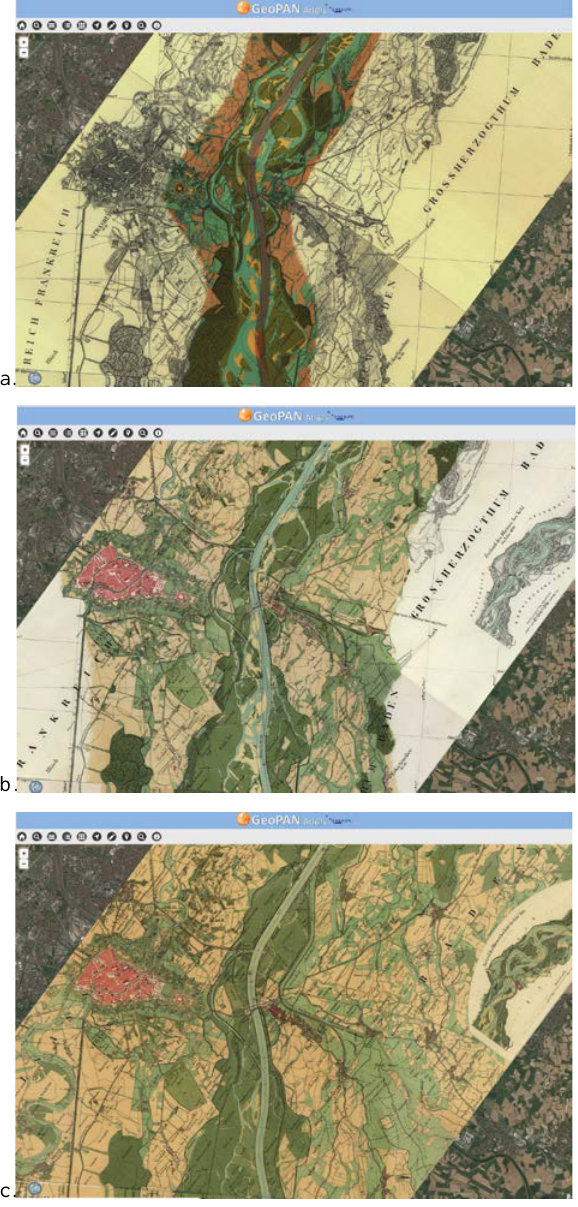
Figure 5. Rhine river in correspondence of Strasbourg: the original riverbed in 1830 (light blue) and the rectification project (red) (a), the riverbed (light blue) in 1852 (b) and 1872 (c).